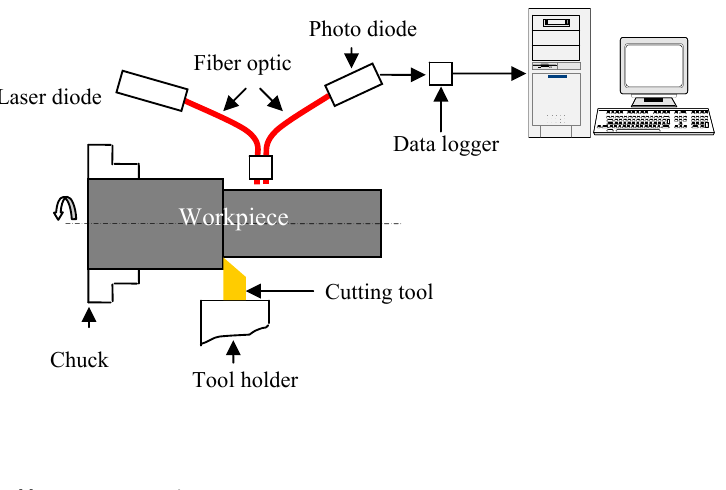
Figure 2. Schematic diagram of the experimental set-up.